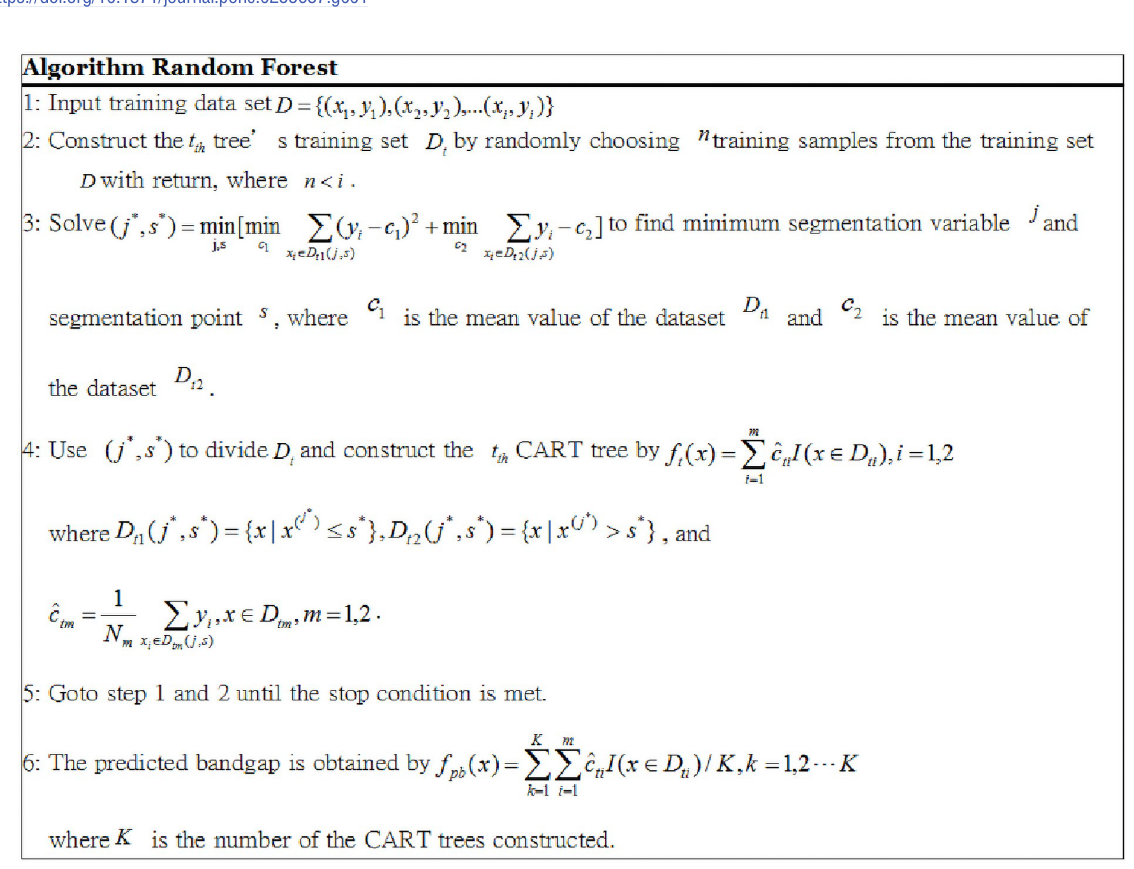
Fig 2. Random forest